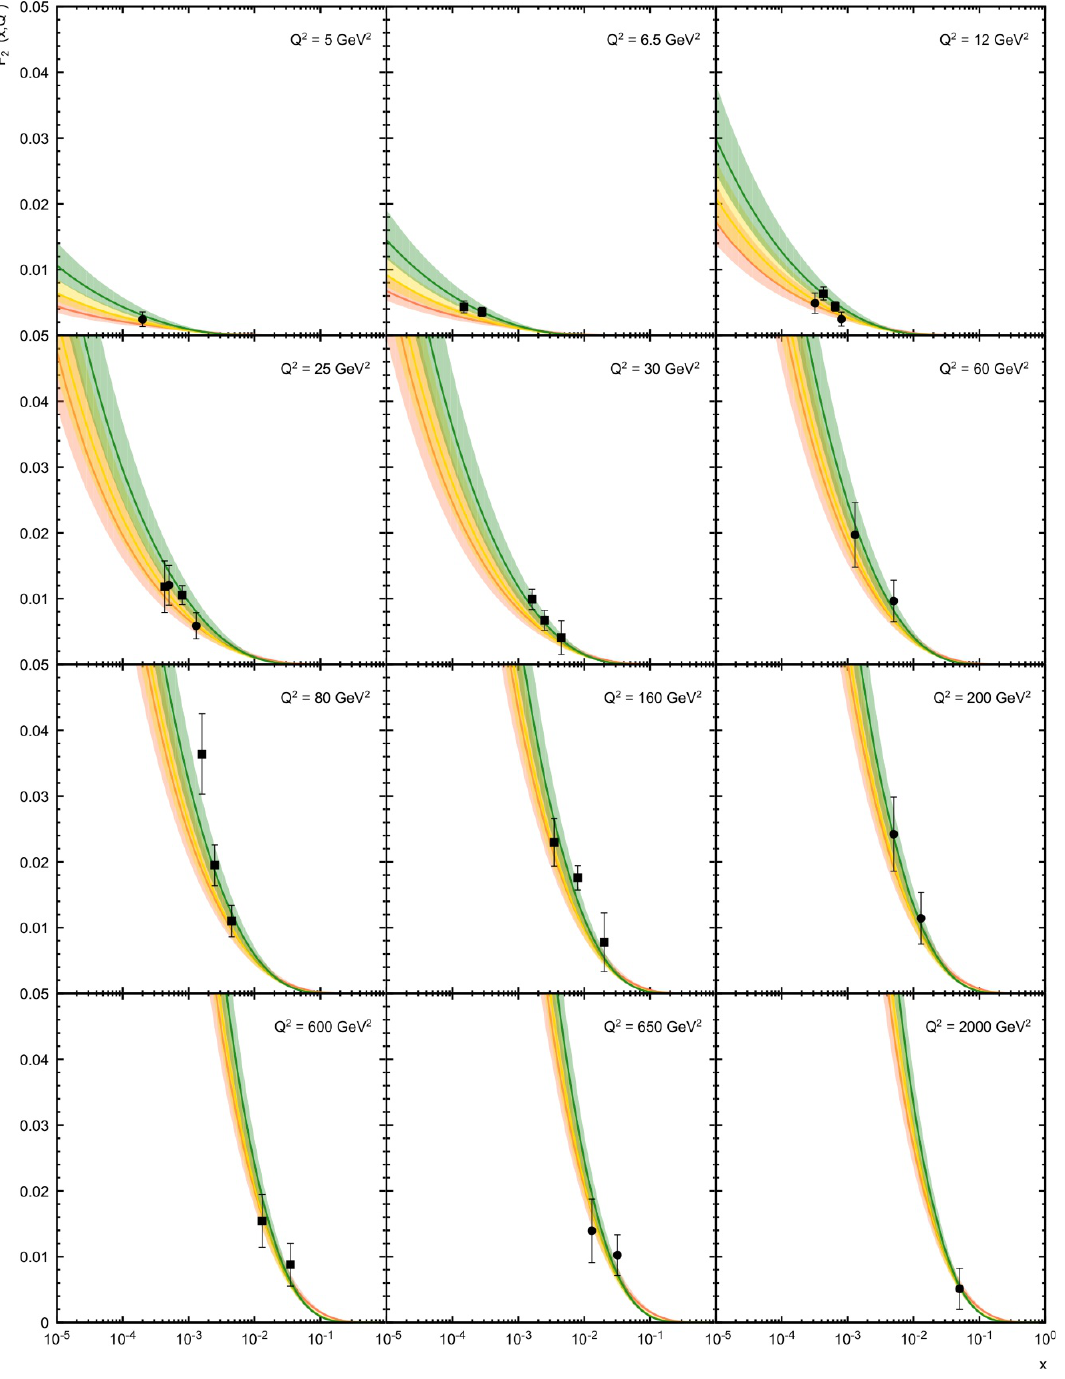
Figure 9 . The beauty contribution to the proton structure function F 2 ( x; Q 2 ) as a function of x calculated at di(cid:11)erent Q 2 . Notation of curves is the same as in (cid:12)gure 1. The experimental data are from ZEUS [99] and H1 [101].